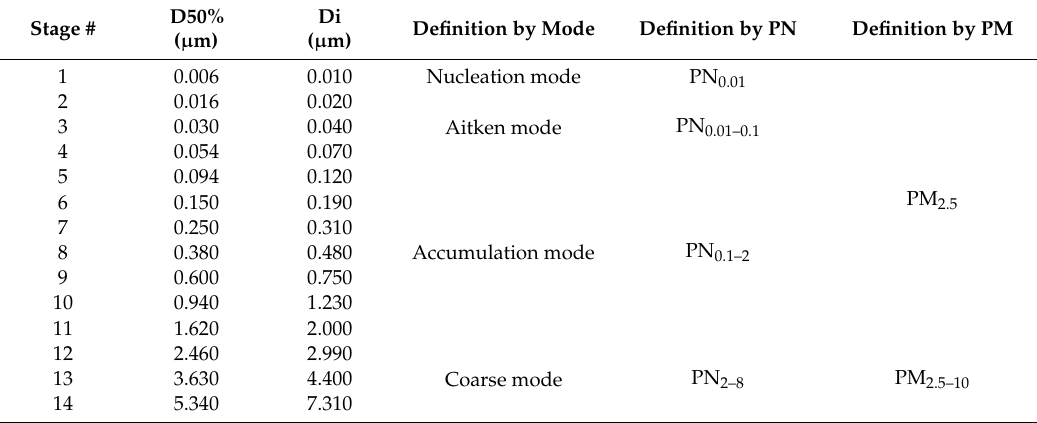
Table A1. The particle size classification of ELPI + TM .